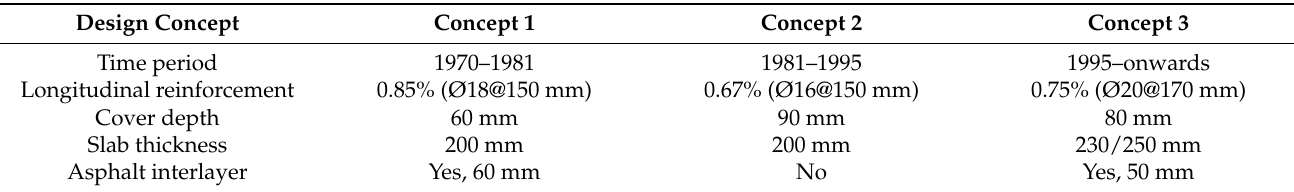
Table 1. Overview of design concepts for continuously reinforced concrete pavement (CRCP) in